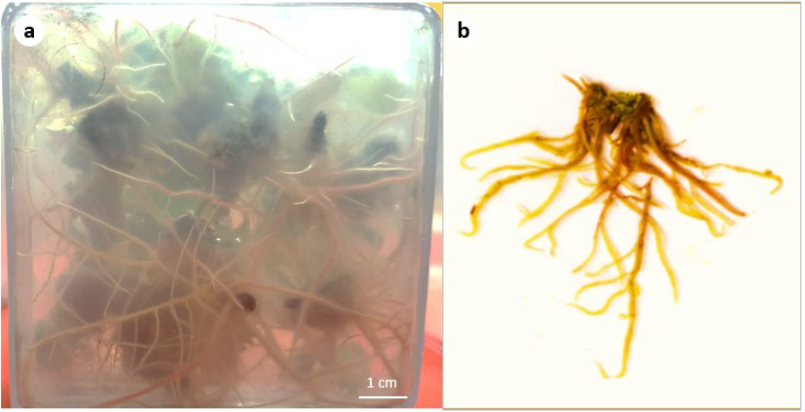
Figure 2. In vitro rooting of blackberry microshoots ( a ) and staining of the adventitious roots ( b ) after 8 weeks in culture.